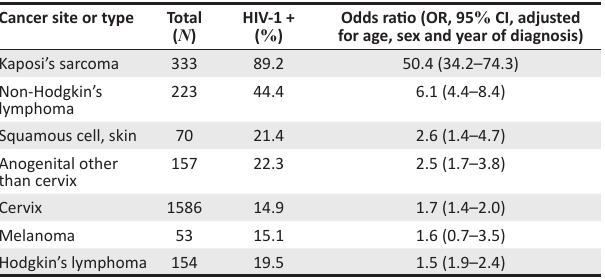
TABLE 4: The association of certain cancers with HIV-1 infection in South Africa, 1995–2004. 63 Cancer site or